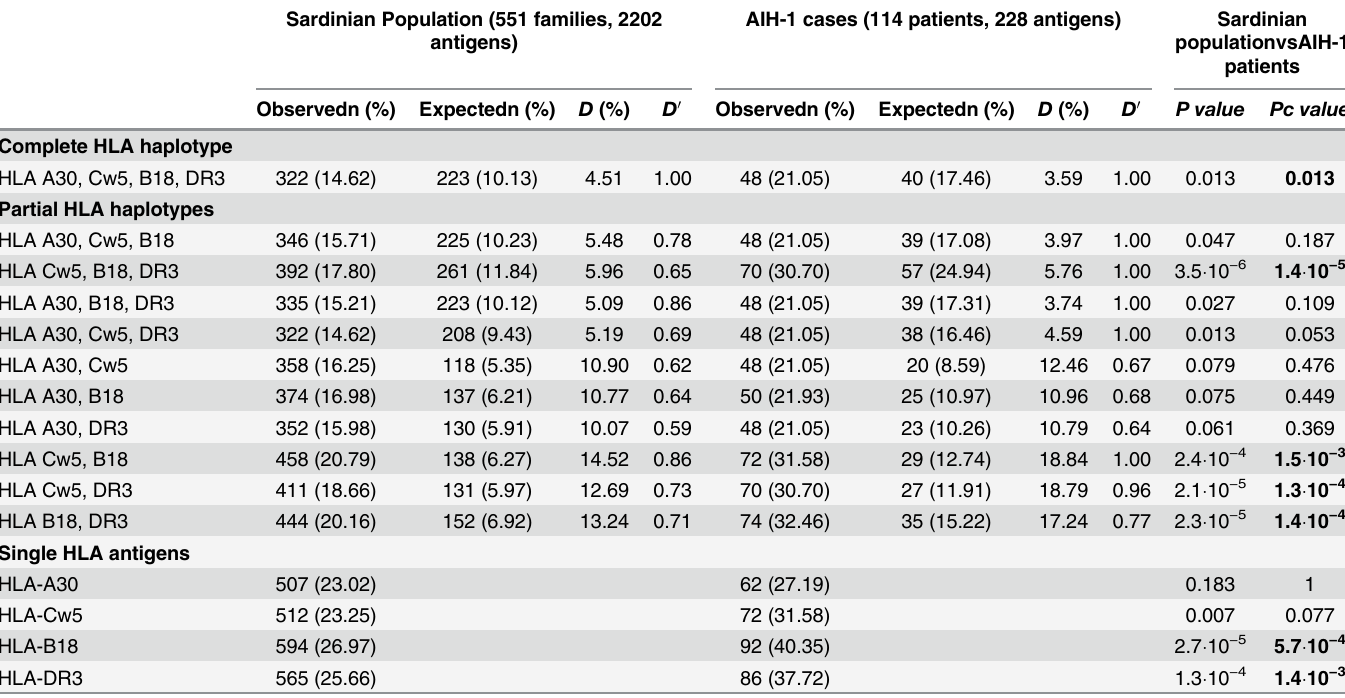
Table 2. Comparison of antigen and haplotype frequencies of AIH-1 patients with those of the Sardinian population. Sardinian Population (551 families, 2202 AIH-1 cases (114 patients, 228 antigens) Sardinian antigens)